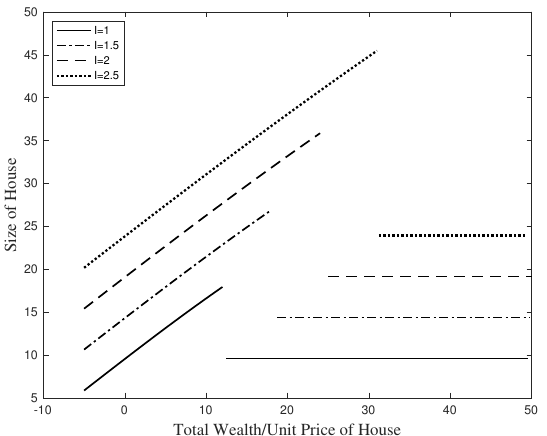
Figure 3. Optimal housing policies with changes in income